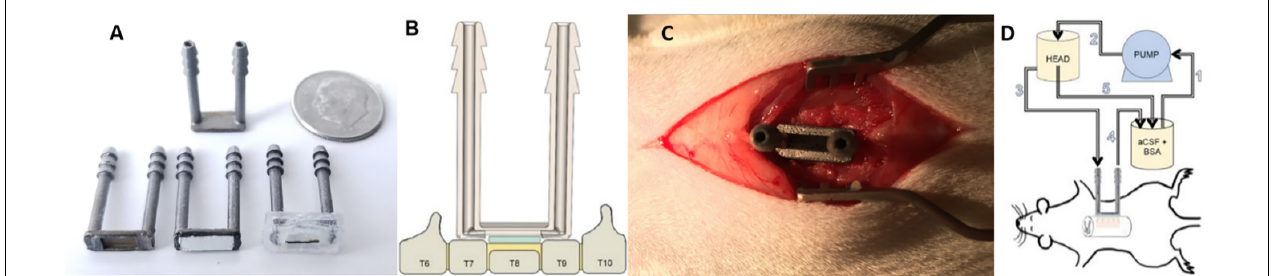
FIGURE 3 | Deployment of the osmotic transport device (OTD) to reduce edema at the site of spinal cord injury. (A) Basic OTD design that consists of a fluid housing chamber with a supported semipermeable membrane bottom. The device consists of 19 mm inlet and outlet ports connected by a shallow chamber at the base of the device. The length of the ports allow for ease of access to the device following wound closure. The bottom of the chamber houses the semipermeable membrane (10 kDa cutoff) adhered to its underside that provides a continuous flow channel between ports for fluid and solutes not permeating the membrane. The device has an additional silicone housing to protect the animal and provide additional sealing. Images counterclockwise from the top: top view of OTD without silicone housing; bottom view of OTD without membrane attached or silicone housing; bottom view of OTD with attached membrane; bottom view of OTD with membrane attached and silicone housing. (B) Following T8 laminectomy and severe contusion spinal cord injury, the dorsal processes of T7 and T9 are removed and flattened. Hydrogel (green) is then placed on the surface of the exposed injury site (yellow) and the OTD is deployed and sealed with additional silicone. The hydrogel provides continuous fluid continuity between the OTD semipermeable membrane and the tissue. (C) Photograph of the OTD deployed in the animal without additional silicone application. (D) Aqueous proteinaceous solution (aCSF + BSA, 350 g/L) is delivered from a reservoir (1) through a pump, which is then transferred